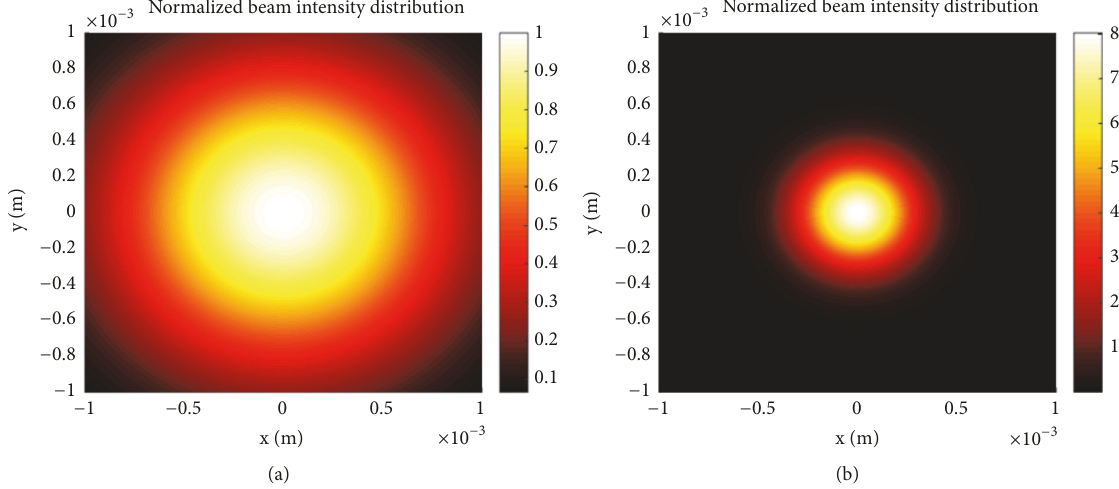
Figure 6: Emerging beam intensity distribution when GB propagates a circle in the ring resonator for two kinds of curvature radius, 𝜔 × 10 −3 m, 𝑛 𝜔 𝜔 2𝜋 ] × √ 2.55 , 𝑍 𝐿 =2 𝑍 𝑅 = 𝑍 𝑙 =0.2m, and 𝜆 =632.8nm fixed: (a) 𝑟 󳨀→ ∞ ; (b) 𝑟 =0.2m. 0 =0.1 𝑟 =1.55, 𝑝𝑒 = 𝑝𝑚 = 𝑅 =4.9646cm, 𝑅 , 𝑅 ,